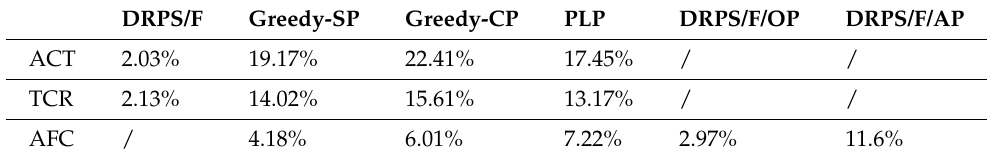
Table 2. Compared with baseline algorithms, the performance improvement of DRPS on three